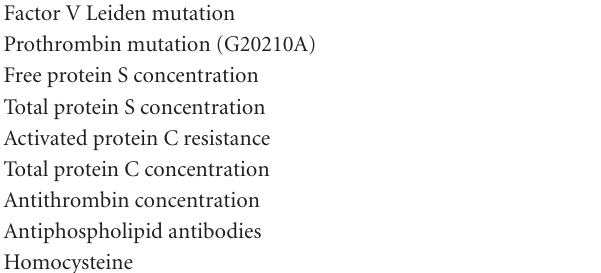
Table 2: Parental screening for